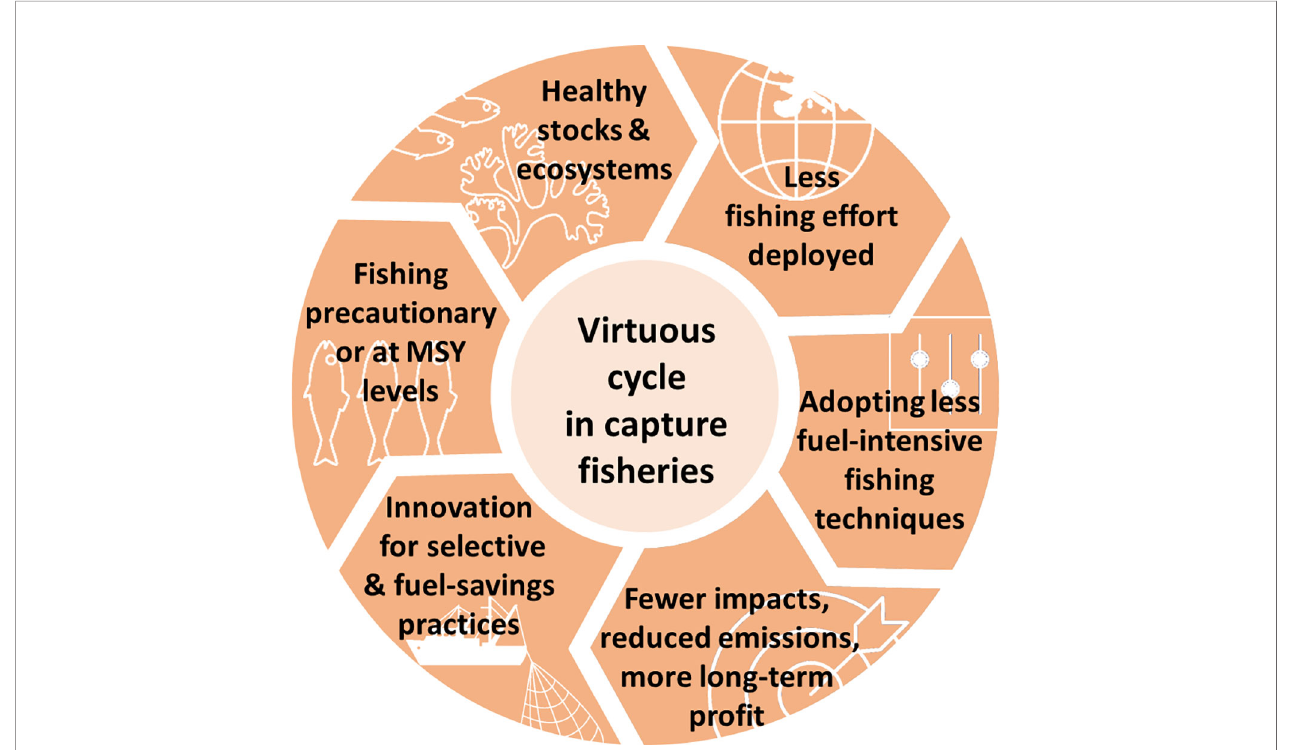
FIGURE 1 | An idealized virtuous circle showing incremental steps that would provide incentives to fi shing vessels deploying selective fi shing gear or using fi shing techniques with reduced environmental impact toward maintaining healthy and productive marine ecosystems supporting the fi sheries and their future